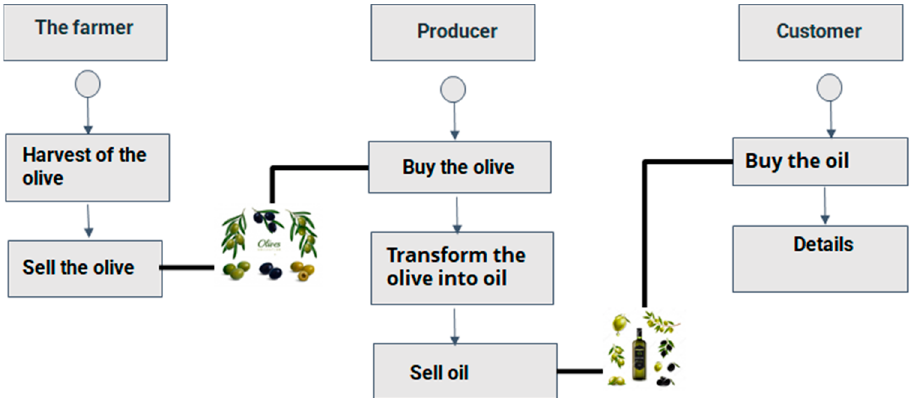
Figure 3. Implemented proposed system.